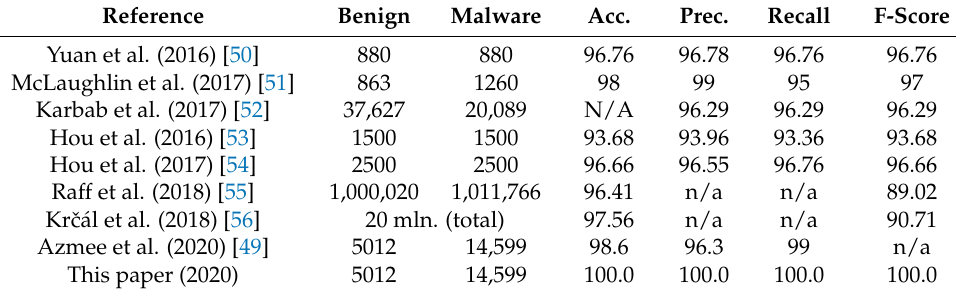
Table 8. Comparisons of with other existing deep learning approaches.